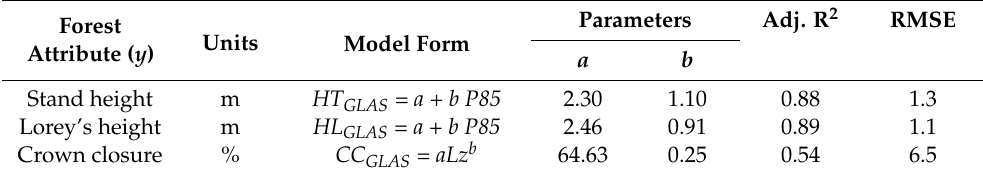
Table 3. Geoscience Laser Altimeter (GLAS) footprint models, parameters, and goodness-of-fit metrics (adjusted (Adj.) R 2 , root mean square error (RMSE)) ( n = 43) (HT GLAS and CC GLAS first reported in Mahoney et al. [8]). P85, height corresponding to the 85th percentile of waveform